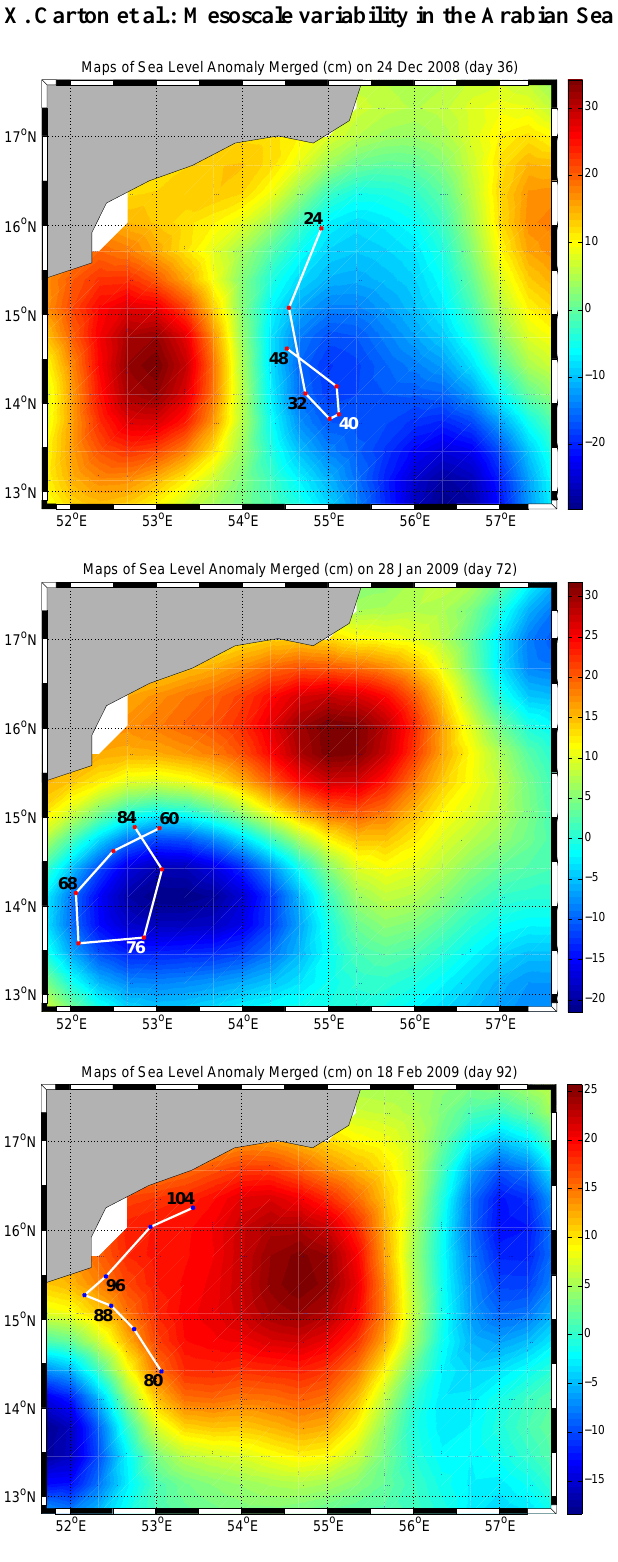
Fig. 21. From top to bottom, sea-level anomaly (SLA) maps of 24 December 2008, 28 January and 19 February 2009 (days 36, 72 and 92 of the mission) with the trajectory of float 1900438 super- imposed. Dots correspond to the position of this float every 4 days. Mission days are indicated next to the dots.